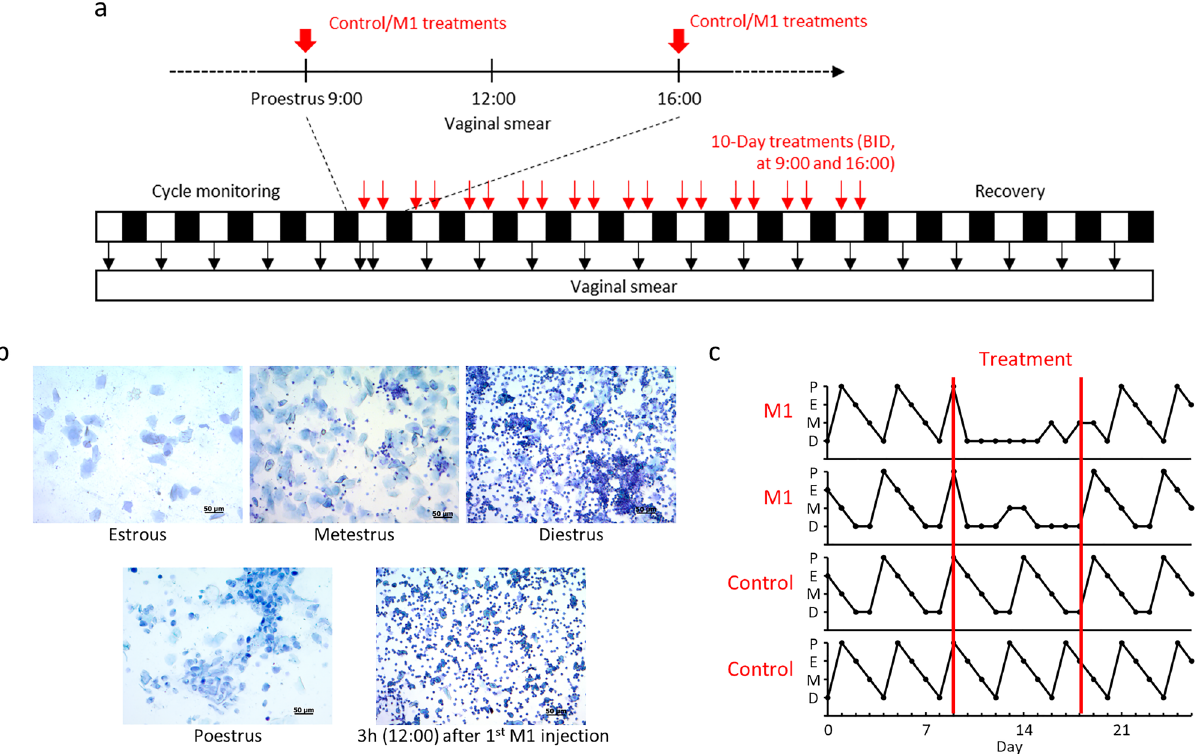
Figure 1. The proestrus M1 injections temporarily disrupted the mouse estrous cycle. A group of 8-week-old ICR mice estrous cycle was observed by vaginal smear for cycle monitoring. After two or more cycles were observed, the mice were treated with M1 or Control treatments (n = 4) twice a day for 10 consecutive days and the mice were then observed to recover ( a ). The figure shows the estrus cycle of the mice from before, during, and after the treatments ( b ). The estrus cycle of the mice was observed by vaginal smears and the comparison of the representative smears 3 h after the first M1 injection was shown ( c